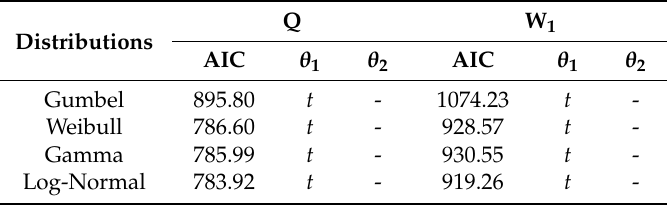
Table 1. The functional relationships of the explanatory variables and distribution parameters.